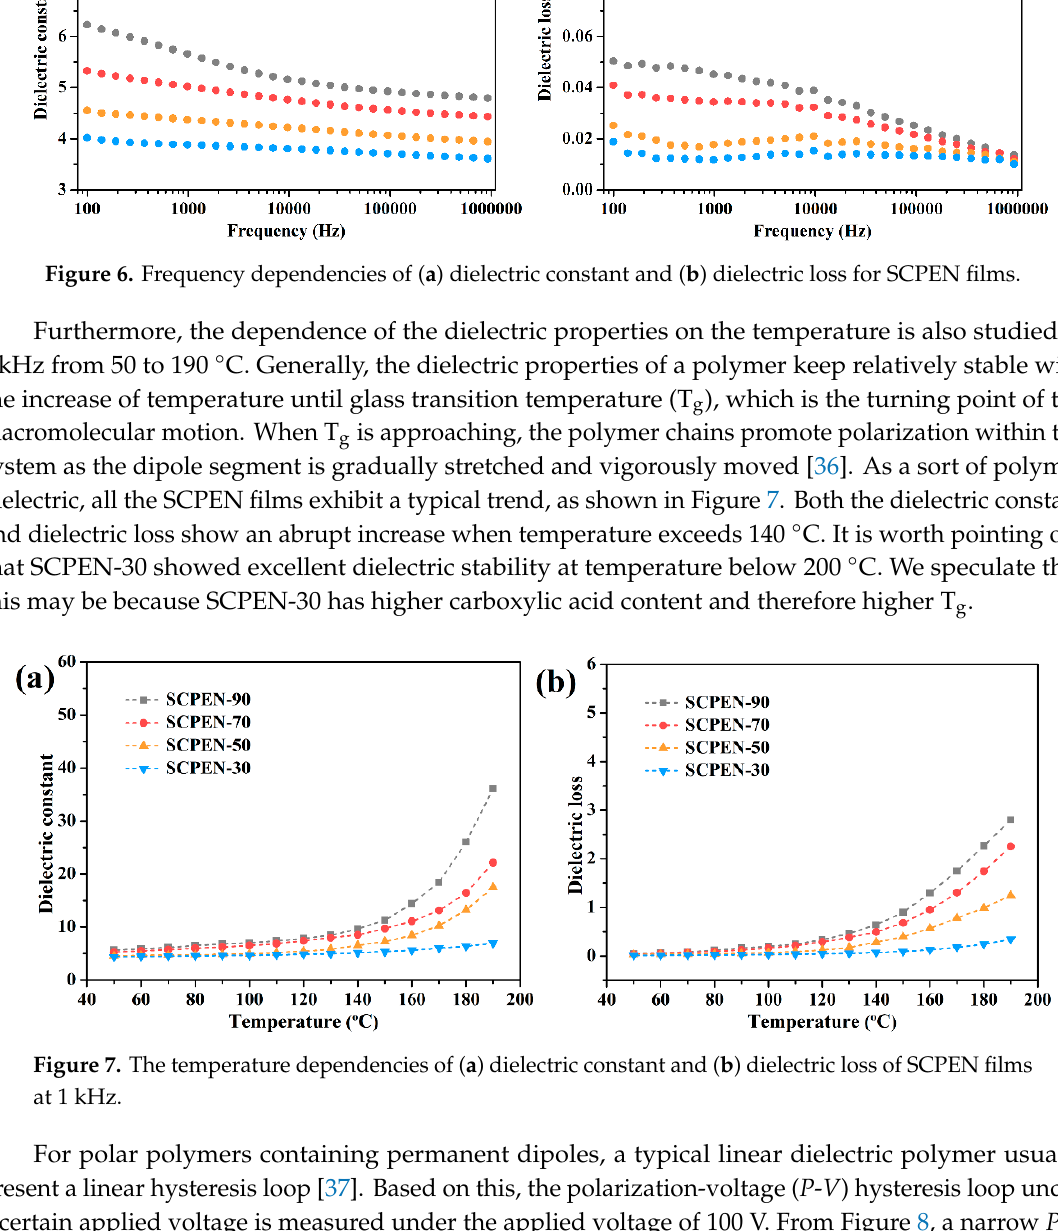
Figure 8. P-V loop of SCPEN film. The electrical breakdown strength of the films is of great significance to the practical application of dielectric materials. Thus, the electrical breakdown strengths of different SCPEN films are measured in detail. The results reveal that the ratio of polar groups pending in the chain leads to a monotonous change in breakdown strength as expected. As shown in Figure 9, the breakdown strength of SCPEN films increases with the increasing –CO 2 H content, which increases from 124.4 to 196.2 kV/mm at room temperature. This phenomenon is in good agreement with the classical theory which was proposed by Stark and Garton [38]. It reveals that the breakdown strength of the polymer film is related to its tensile modulus. The breakdown strength tends to be improved by the enhancement of the tensile modulus. The high dielectric breakdown is mainly due to the absence of defects on the film, which has been confirmed by SEM. The side groups pending on the main chain bridge the relationship between the dielectric constant and breakdown strength. On the one hand, the increasing sulfonic groups (–SO 3 H) provide opportunities for enhancing the dielectric constant for polymers, as a result of intensive orientation polarization of highly polar groups. On the other hand, carboxylic groups (–COOH) contribute to the improvement in breakdown strength. This could be attributed to the following mechanism: The